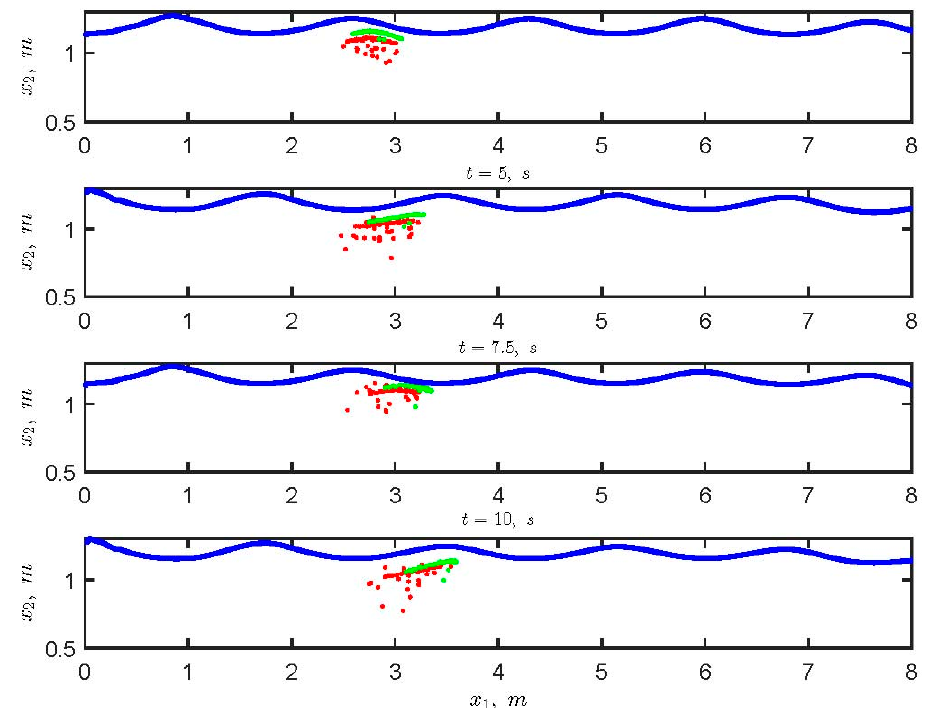
Figure 7. Particle positions at different times. Particles of diameter 1000 μ m are represented with green points and the red points represent particles of diameter equal to 100 μ m. Each group has 50 particles that are tracked during 10 wave periods. Starting point of all particles was at x 2 = 1.10 m. J. Mar. Sci. Eng. 2018 , 6 , 7 11 of 17